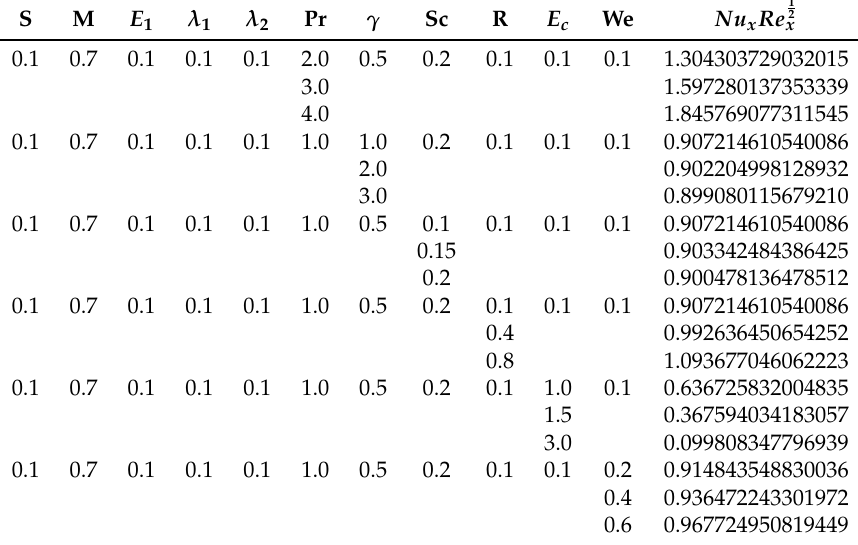
1 2 x for different values of the parameters We , S , M , E 1 , λ 1 , λ 2 ,